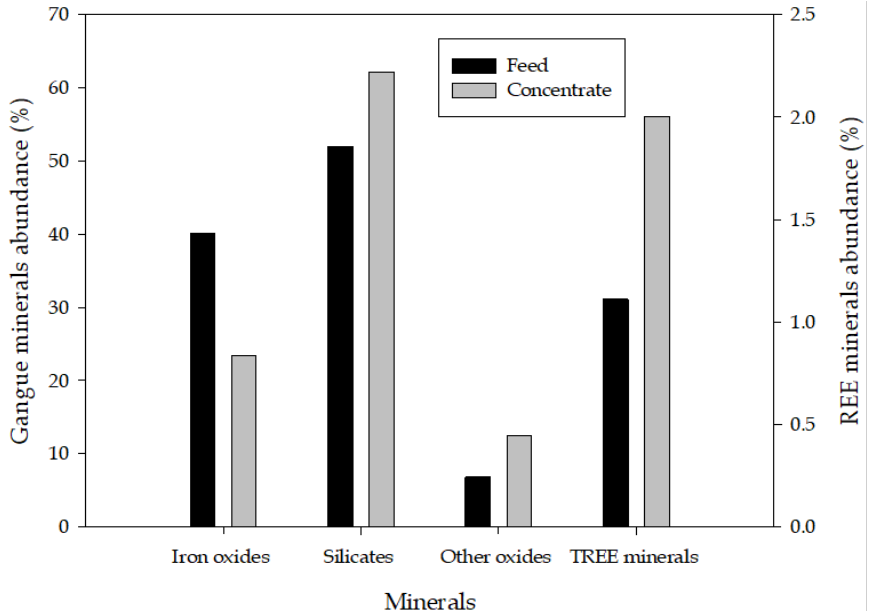
Figure 2. Mineral mass abundance of TREE and gangue minerals in the flotation feed and concentrate from Flowsheet A in Figure 1 [1].